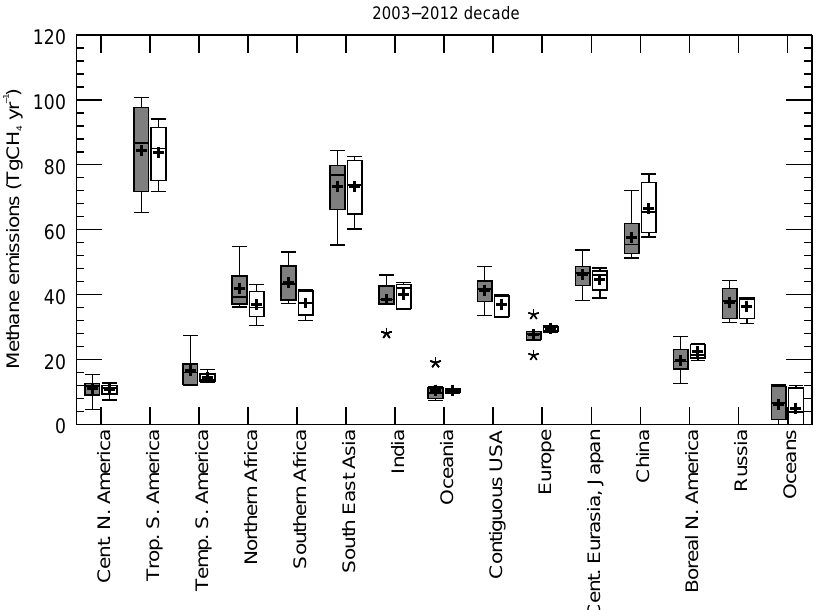
Figure 6. Regional methane emissions for the 2003–2012 decade from top-down inversions (grey) and for the prior estimates used in the inversions (white). Each boxplot represents the range of the top-down estimates inferred by the ensemble of inversion approach. Median value, and first and third quartiles are presented in the box. The whiskers represent the minimum and maximum values when suspected outliers are removed (see Sect. 2.2). Outliers are marked with stars when existing. Mean values are represented with “ + ” symbols; these are the values reported in Table